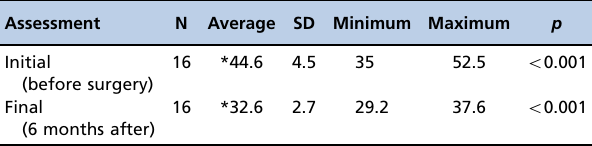
Table 1 - Descriptive statistics for body mass index (kg/m 2 ) at the time of initial surgery (early time) and at 6 months after surgery. Assessment